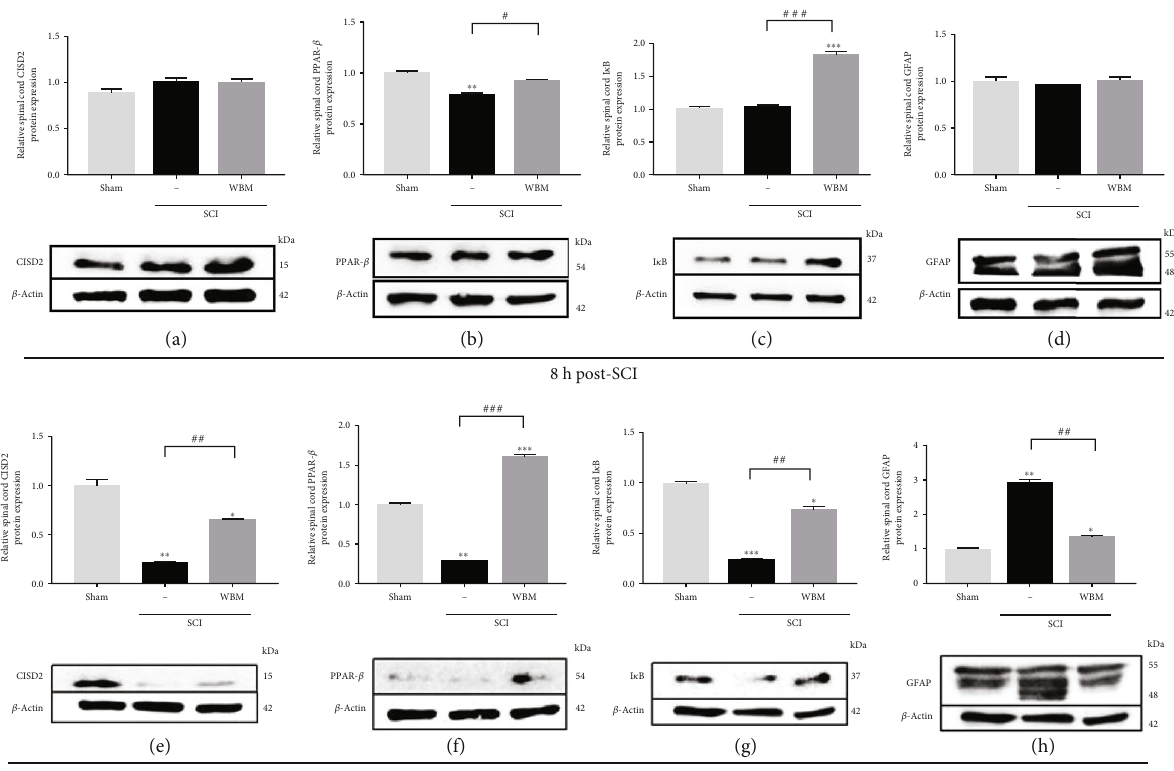
Figure 5: WBM abolished injury-triggered GFAP and attenuated injury-downregulated CISD2, PPAR- β , and I κ B protein expression in mice 24h following spinal cord hemisection in vivo . (a – d) In vivo mouse model of SCI. Results of protein expression of CISD2 (a), PPAR- β (b), I κ B (c), and GFAP (d) for 3 conditions 8 h after SCI. (e – h) Results of protein expression of CISD2 (e), PPAR- β (f), I κ B (g), and GFAP (h) for 3 conditions 24h after SCI. The lower panel indicates representative immunoblot of the proposed protein expression, and β -actin (42 kDa) serves as an internal control. The results shown were from one of the experiments that were repeated for at least 3 times. The upper panel indicates the mean ± SEM of the proposed protein/ β -actin band intensity in ratio to the control group. Anti-in fl ammatory e ff ects of WBM on SCI can be postulated as CISD2 preservation, and the potential upstream regulation of CISD2 on PPAR- β , subsequent I κ B stabilization, and therefore, NF- κ B inhibition. Vertical bars indicate the mean ± standard errorof the mean (SEM) of protein expression ( n = 3 ). ∗ P < 0 : 05 vs. control, ∗∗ P < 0 : 01 vs. control, ∗∗∗ P < 0 : 001 vs. control, # P < 0 : 05 , ## P < 0 : 01 , and ### P < 0 : 001 indicate a signi fi cant di ff erence. Pair-wise multiple comparisons between groups were performed using the Newman-Keuls